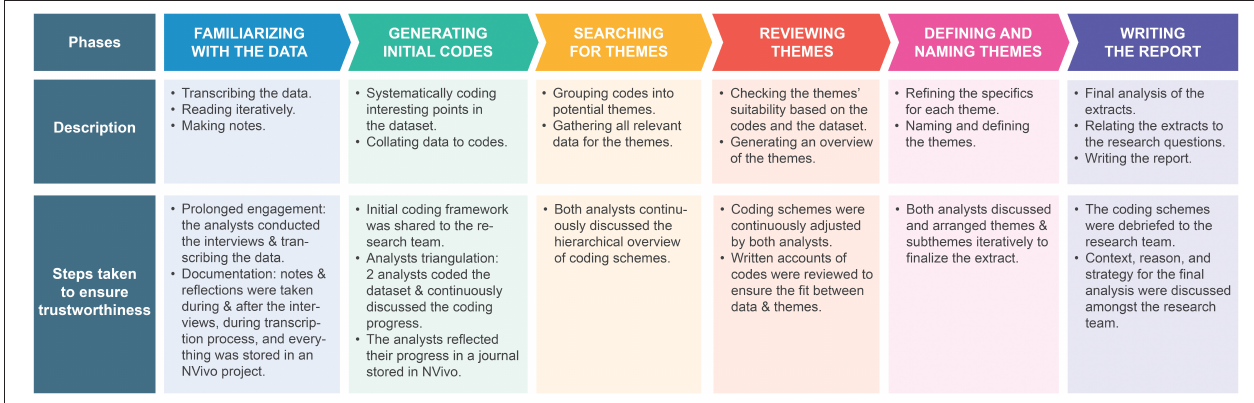
FIGURE 1 | An overview of the six-step analysis and trustworthiness measures per stage.